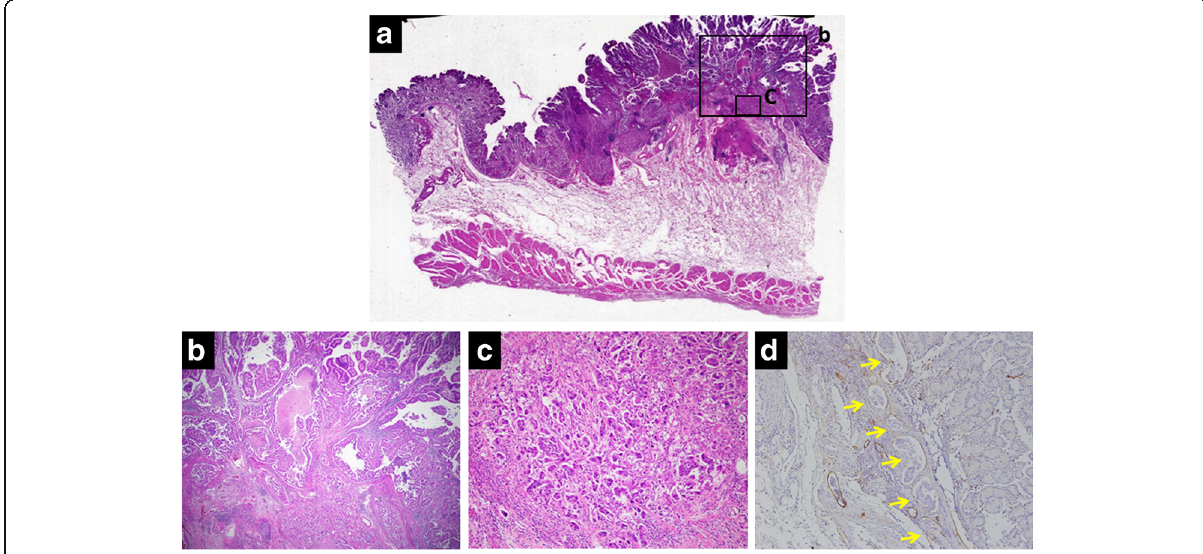
Fig. 4 Histopathological examination of the angular region showed the other elevated lesion ( a ). The lesion was a well-differentiated adenocarcinoma in the mucosa ( b ), becoming more poorly differentiated as it invaded the submucosa ( c ). Prominent lymphatic permeation was detected by immunohistochemical staining with D2-40 (arrow) ( d ). ( a low-power view, b high-power view of square, × 2 objective lens; c high- power view of square, × 10 objective lens; d high-power view, × 10 objective